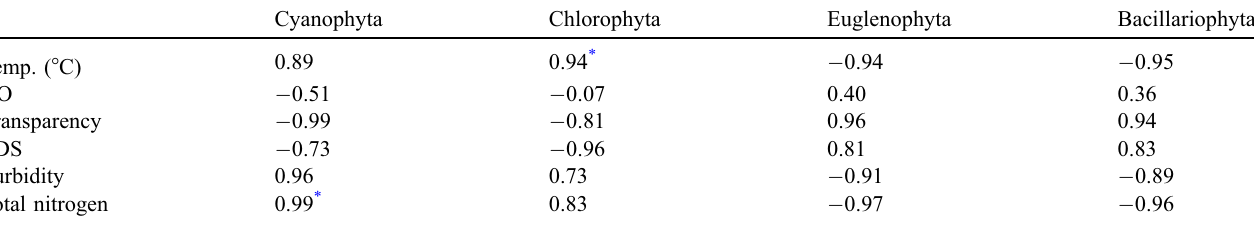
Table 3. Correlation coef fi cients found by a partial correlation analysis of phytoplankton group (average count) and various environmental factors in Lake Chamo